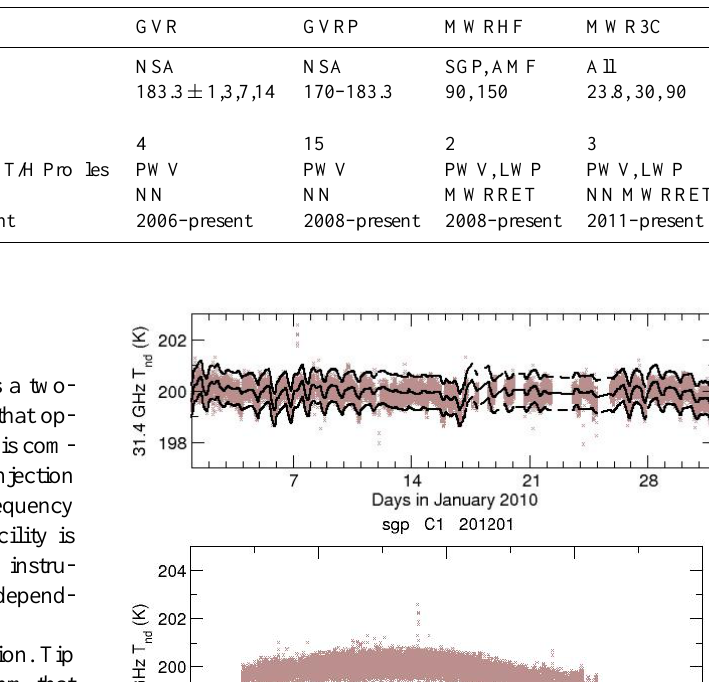
Table 1. Location, frequency range, date range of the ARM microwave radiometers and currently available retrievals.